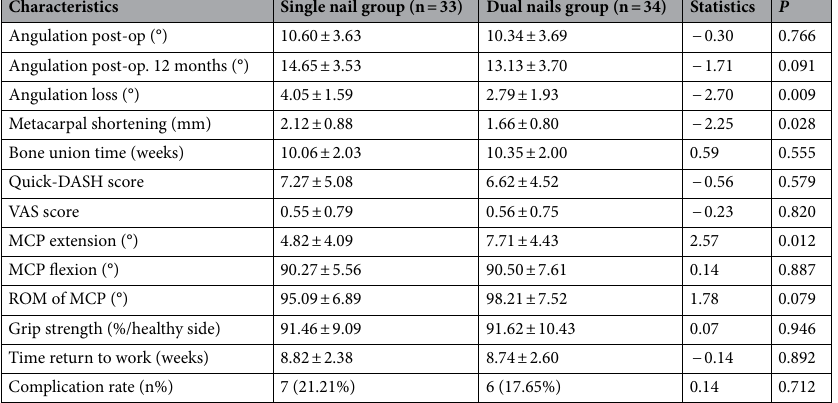
Table 2. Clinical and radiological outcomes of both groups. DASH Disabilities of the arm, shoulder, and hand questionnaire; VAS visual analogue scale; MCP metacarpophalangeal joint; ROM range of